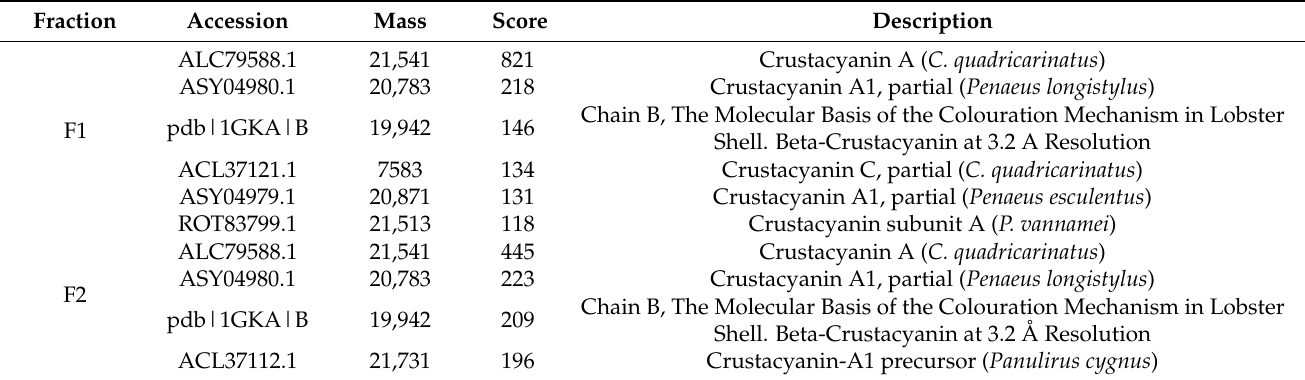
Figure 4. Purification of red-change-related pigment proteins by size exclusion chromatography. ( a ) Elution size exclusion chromatography profile. ( b ) SDS-PAGE profiles of the crude pigment proteins and purified fractions F1, F2, and F3. (Lane M is the protein markers.) Table 1. Comparison of the peptide sequences of the 21 kDa subunit of F1 and F2 derived from P. clarkii and matched proteins in the NCBI